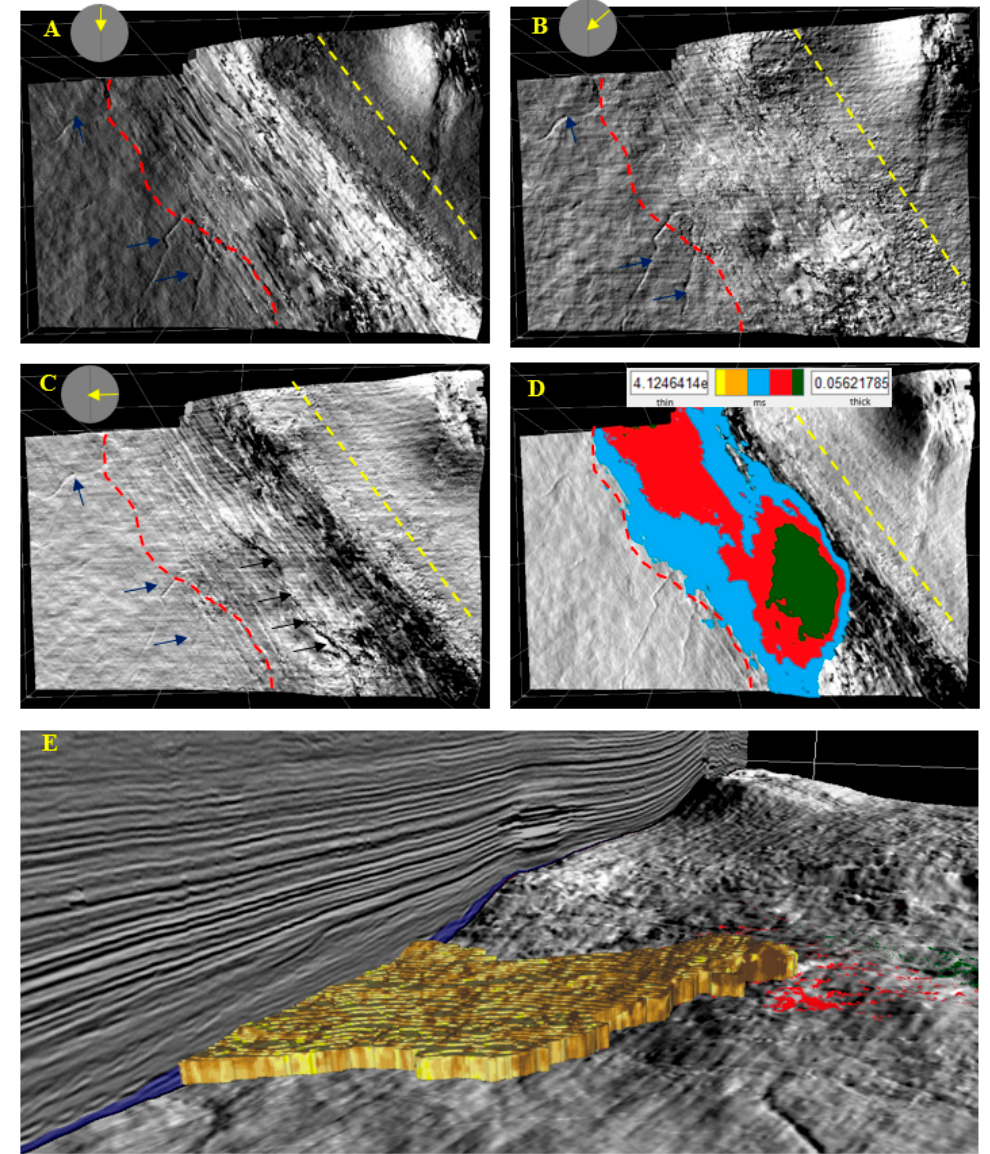
Figure 12. The apparent dip attribute for BSFR1 surfaces at ( A ) 0°, ( B ) 45°, ( C ) 90°, ( D ) the Isopach map, and ( E ) 3D turbidite geobody extraction where darker shades indicate mud-rich turbidite while lighter shades indicate sand-rich turbidite. The blue arrows indicate the deep meandering channels and the black arrows indicate the existence of a major fault.